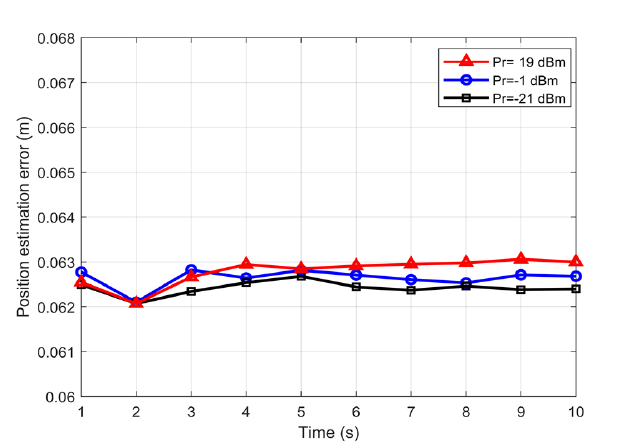
Figure 4. The estimated position error as a function of time for different power levels using a minimax filter, assuming an ideal